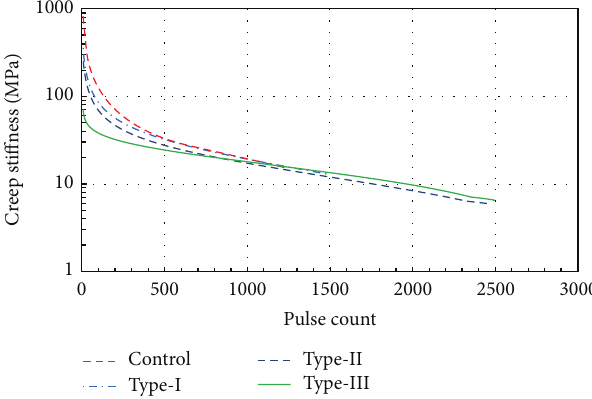
Figure 6: Static creep stiffness curves with respect to rubber type and time.